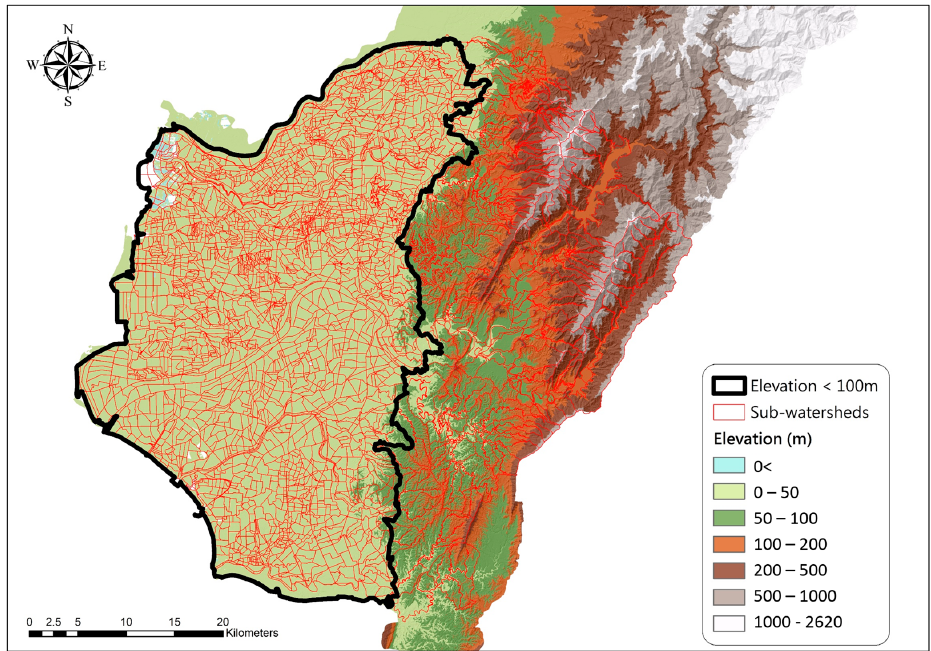
Figure 8. Partition (or delineation) of sub ‐ watersheds.